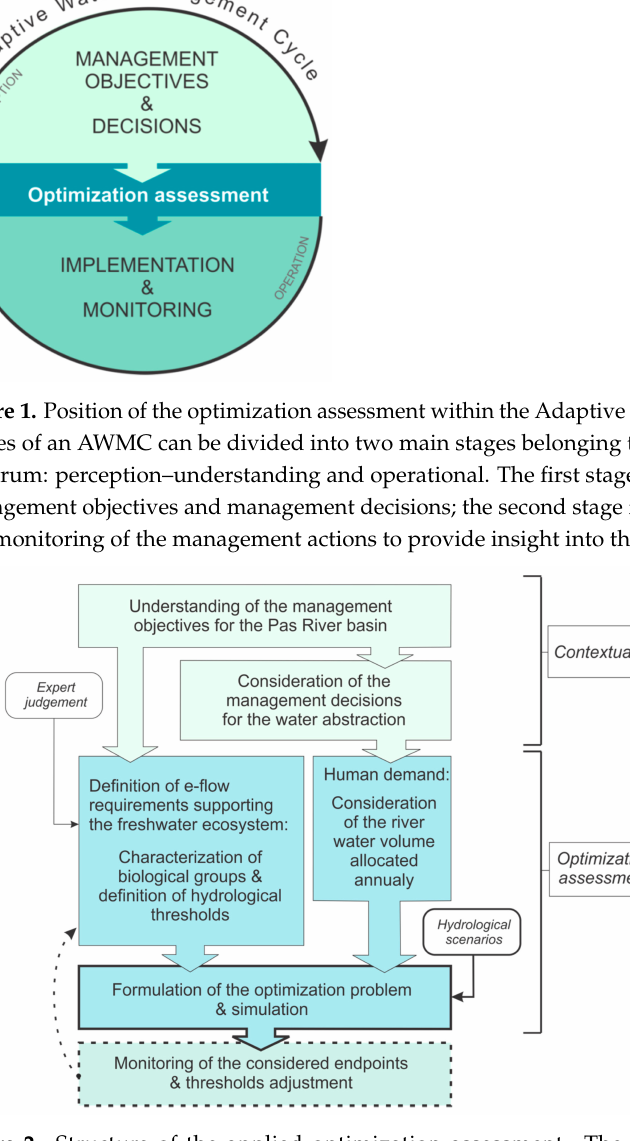
Figure 2. Structure of the applied optimization assessment. The case study description phase considers information that arises from the current management decisions, and it was used for the optimization assessment development. The bold outlined box corresponds with the monitoring phase that was not assessed in this study but serves to highlight the link with the Adaptive Water Management Cycle (left-hand